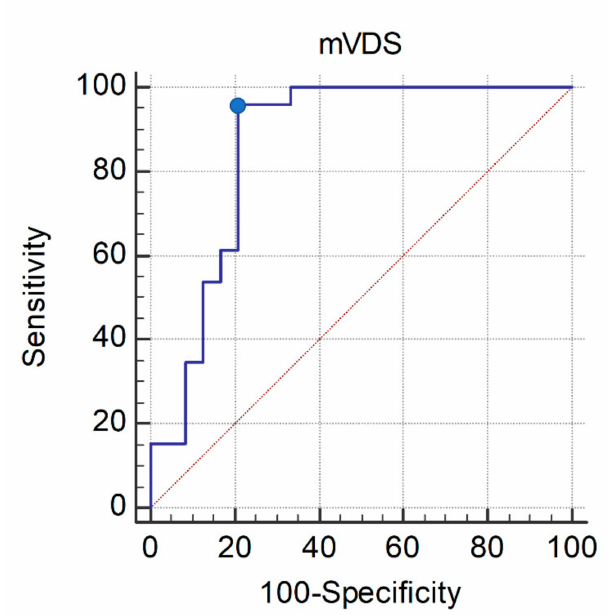
Figure 1. ROC curve of the mVDS score for the allowance of oral feeding in patients with dysphagia due to deconditioning or frailty. The optimal cutoff value (dots on the curves) of the mVDS score, which was obtained from the maximal Youden index, was ≤ 48 (AUC, 0.862; 95% CI, 0.747–0.978; p < 0.0001; sensitivity, 96.15%; specificity, 79.17%). ROC, receiver operating characteristic; AUC, area under the receiver operating characteristic curve; CI, confidence interval; mVDS, modified version of the videofluoroscopic dysphagia